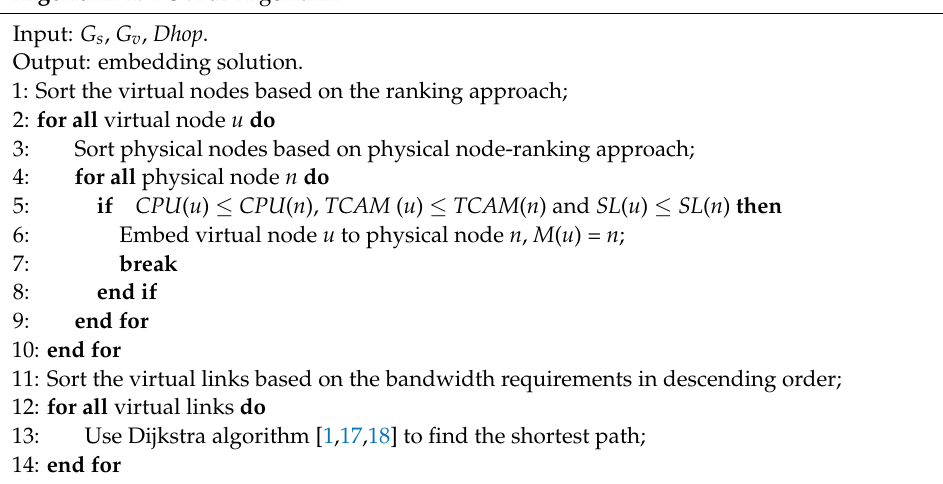
Algorithm 1: T-SVNE Algorithm